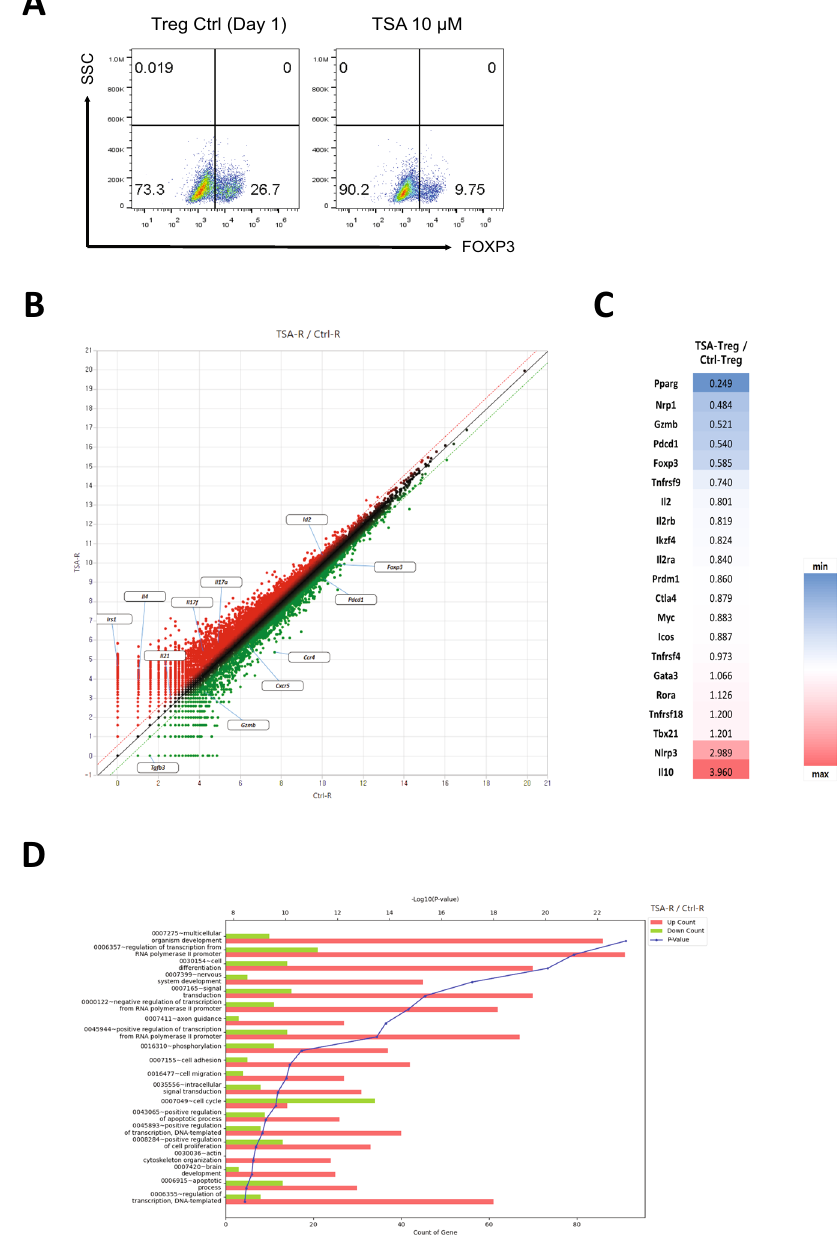
Figure 4. Global gene expression analysis by RNA-seq. ( A ) Naïve CD4 + T cells were differentiated for 1 day into Treg cells in the presence of vehicle (control) or TSA (10 μM). The percentage of FOXP3 + cells was analyzed by flow cytometry. ( B ) Scatter plot of RNA-seq data. RNA-seq analysis was conducted using total RNA isolated from control or TSA-treated Treg cells after 1 day of culture. Genes upregulated (-fold change > 2.0) are shown in red; genes downregulated (-fold change > 2.0) are shown in green. ( C ) Heat map of -fold changes shows expression of Th- and Treg-associated genes. Red and blue represent high and low levels of expression of the indicated genes, respectively. ( D ) GO analysis of differentially expressed genes in control or TSA-treated Treg